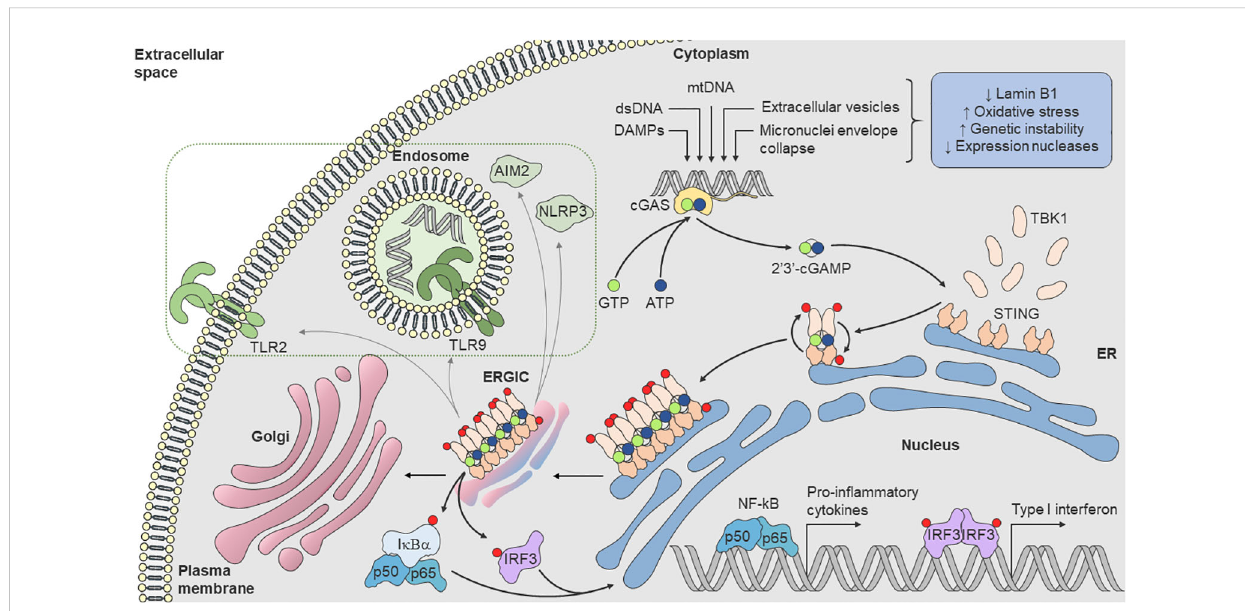
FIGURE 1 cGAS-STING pathway. Loss of Lamin B1, increased oxidative stress, genomic instability, mitochondrial dysfunction, as well as reduced expression of nucleases, lead to dsDNA break and accumulation in cytosol. Cytoplasmic cGAS recognizes dsDNA and synthetizes the endogenous secondary messenger 2 ’ 3 ’ -cGAMP, which in turn, activates the ER transmembrane protein STING. cGAMP binds to STING, oligomerizes and becomes active with translocation to ERGIC. During translocation, STING recruits TBK1 [(D or E)xPxPLR(S or T)D] motif (in which “ x ” denotes any amino acid) and induces its phosphorylation, leading to the recruitment of IRF3. TBK1 phosphorylates IRF3, leading to dimerization and translocation into the nucleus, where it induces transcription of genes encoding various cytokines, chemokines, and interferons. Activated TBK1 also phosphorylates I k B a , the inhibitor subunit of the IKK complex, promoting the release of the heterodimer p50/p65 (NF- k B), which translocates with IRF3 into the nucleus, providing a synergistic pro-in fl ammatory response. STING can also undergo numerous conformational changes that can also trigger the activation and increased expression of AIM2 and NLRP3 in fl ammasomes and TLR2 expression and TLR9 pathway response (dashed rectangle). AIM2, absent in melanoma 2; cGAS, cyclic GMP – AMP synthase; 2 ’ 3 ’ -cGAMP, cyclic guanosine monophosphate-adenosine monophosphate; ER, endoplasmic reticulum; ERGIC, endoplasmic-reticulum – Golgi intermediate compartment; IKK, inhibitor k B kinase; I k B a , NF- k B inhibitor a subunit; IRF3, interferon regulatory factor-3; NF- k B, nuclear factor k B; NLRP3, nucleotide-binding oligomerization domain-like receptor protein 3; STING, stimulator of interferon genes; TBK1, TANK-binding kinase-1; TLR, Toll-like